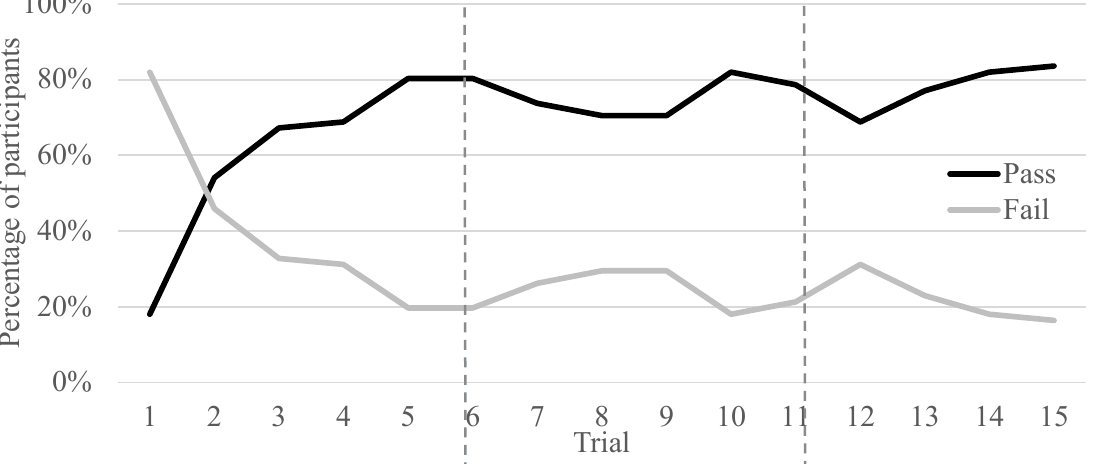
Figure 6. Percentage of participants to pass and fail on each trial. Note: Dotted vertical lines designate the breaks when restarting Pedals Emergency Stop©.